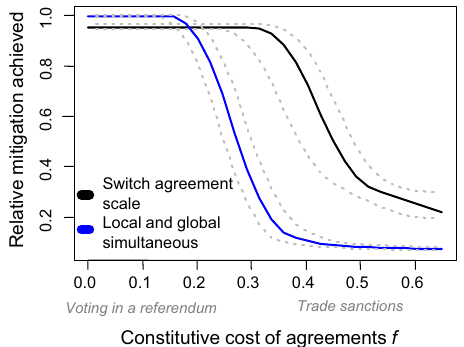
Fig. 3 Shifting agreement scale (black, b = 0) outperforms simultaneous local and global agreement attempts to promote mitigation (blue, b = 0.5) above low constitutive agreement costs f . f denotes the fraction of mitigator costs p M incurred at all times, regardless of whether sanctioning agreements are in effect. Solid lines denote means and dotted lines denote the 25th and 75th quantiles in mitigation achieved by time step 625 across 30 replicate trials. For b = 0, shift from local to global negotiations happens at T = 0.4; all other parameters values listed in Supplementary Fig.